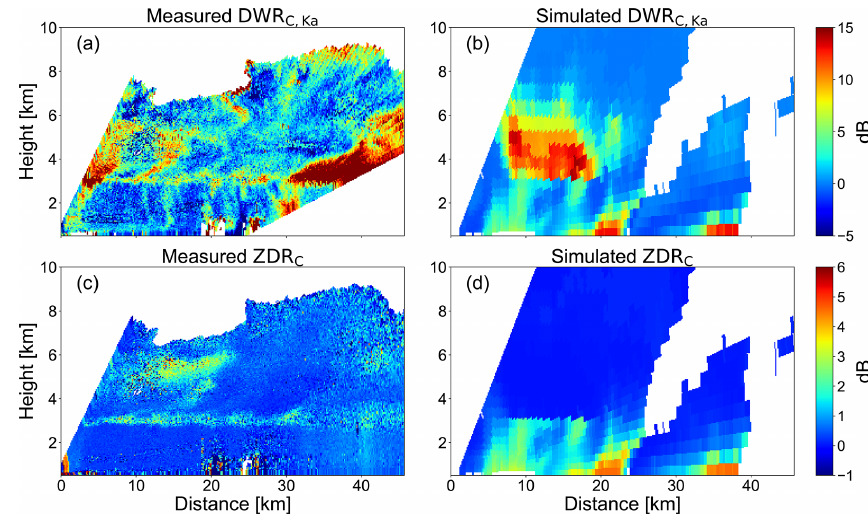
Figure 2. (a) Dual-wavelength ratio between the C-band POLDIRAD and Ka-band miraMACS measurements on 7 July 2019, (b) simu- lated dual-wavelength ratio, (c) differential radar reflectivity Z DR measured by the C-band radar POLDIRAD, and (d) simulated Z DR of a comparable, but not identical, precipitation event using the P3 scheme (Morrison and Milbrandt,